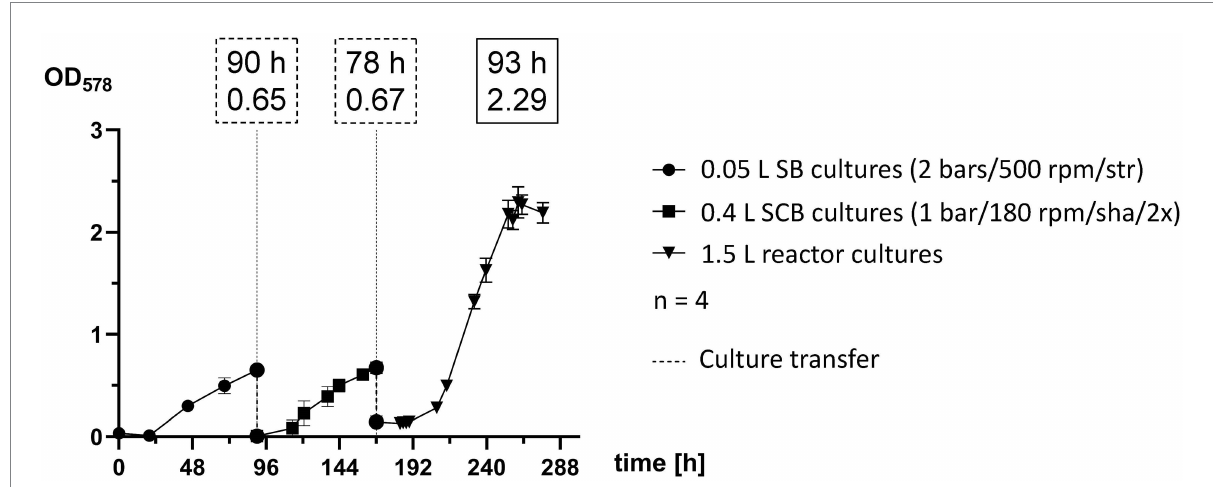
FIGURE 4 Scale-up pipeline of M. maripaludis . OD 578 (left Y axis) measured over time in h for replicates subjected to the following cultivation methods: 0.05 L SB cultures cultivated at 2 bars H 2 /CO 2 and agitated by stirring at 500 rpm (0–90 h); SCB cultivated at 1 bar H 2 /CO 2 twice (2×) a day and agitated by shaking at 180 rpm (90–168 h); 1.5 L reactor cultures subjected to adaptation round setup (168–277 h). Dotted line for culture transfer designates harvesting and inoculation procedures between the distinct groups. All data points are calculated mean values of biological quadruplicates ( n = 4). Dotted text boxes designate time (h) and OD of cultures during transfers. The solid text box designates time (h) of peak OD.